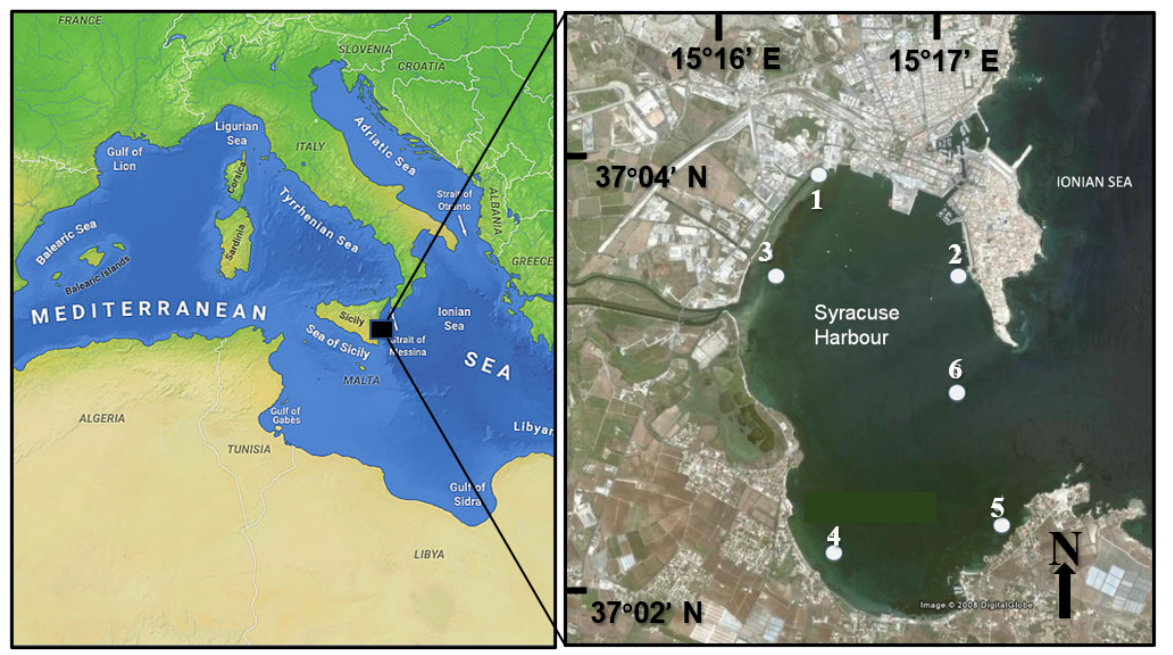
Figure 1. Syracuse Bay. Location of the sampling stations.